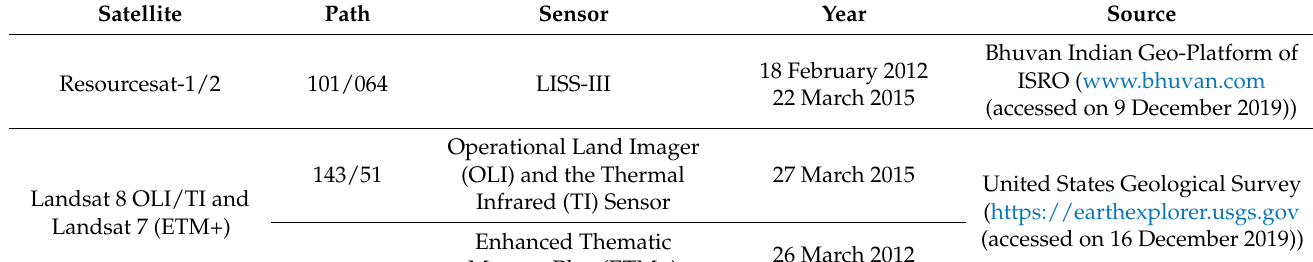
Table 1. Characteristics and sources of the satellite images.